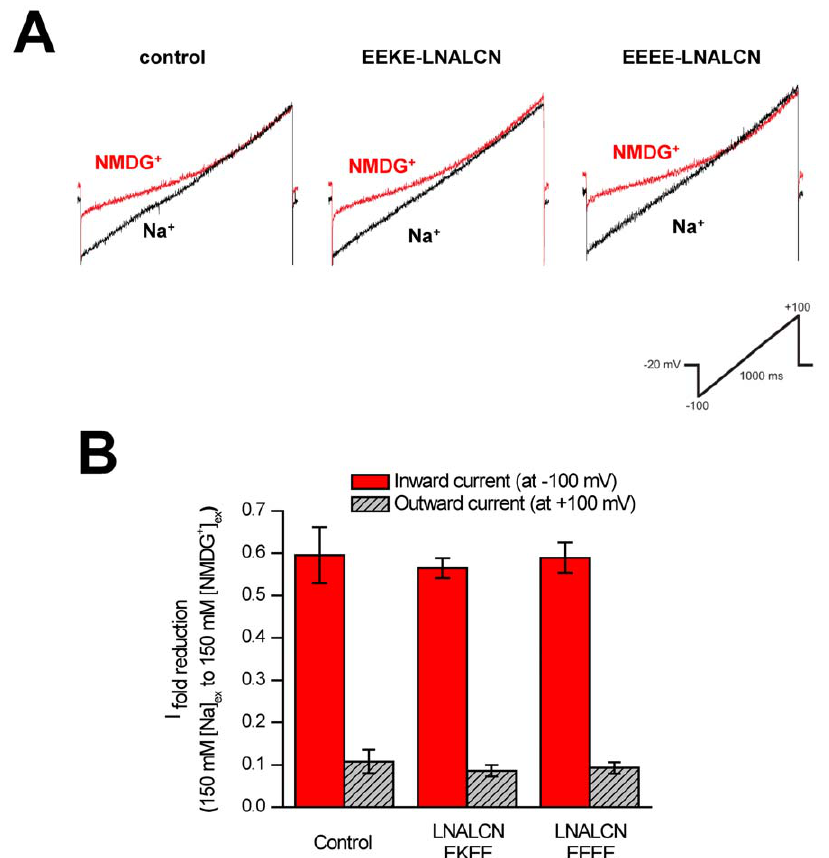
Figure 7. Leak currents from snail NALCN-expressing HEK-293T cells were indistinguishable from those in control cells lacking NALCN. (A) Sample traces showing the block of inward current when replacing 150 mM external sodium (black bars) with NMDG + (hatched). HEK- 293T cells were co-transfected with either 1 m g of Lymnaea NALCN pore variants (EKEE or EEEE) in bicistronic pIRES2-DsRed2, or empty pIRES2- DsRed2 vector for control, plus 1 m g of human Unc-80 in pIRES2-EGFP (enhanced green fluorescent protein), and 1 m g of a constitutively active SRC kinase (Y529F) in a pUSEamp vector. Leak currents, recorded under whole-cell voltage clamp using a ramp protocol (inset), were observed under all conditions. (B) A similar reduction in both inward and outward currents (i.e. at -100 mV and + 100 mV respectively) was observed when 150 mM external sodium was replaced with impermeant cation NMDG + via perfusion (control n=5; EKEE n=7; EEEE n=4).